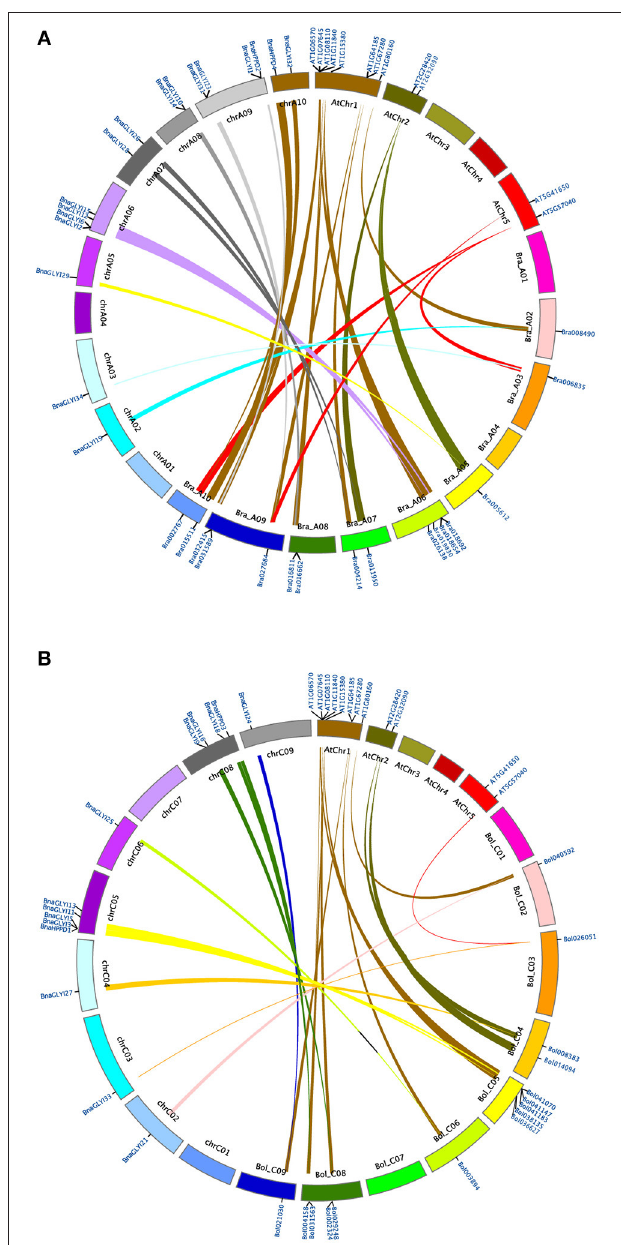
FIGURE 3 | Synteny analysis map of VOC gene in B. napus , B. rapa, B. oleracea, and A. thaliana chromosomes. (A) Genes located on B. napus A genome are syntenic with genes of B. rapa and A. thaliana . (B) Genes located on B. napus C genome are syntenic with genes of B. oleracea and A. thaliana . The different degrees of thickness of lines indicate their synteny relationship (thick, strong; thin, weak).